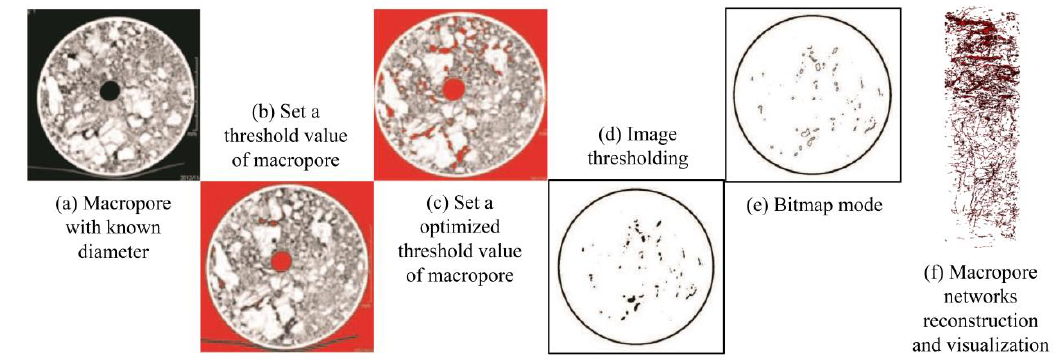
Figure 3. The process of reconstruction and visualization of soil macropores [22].